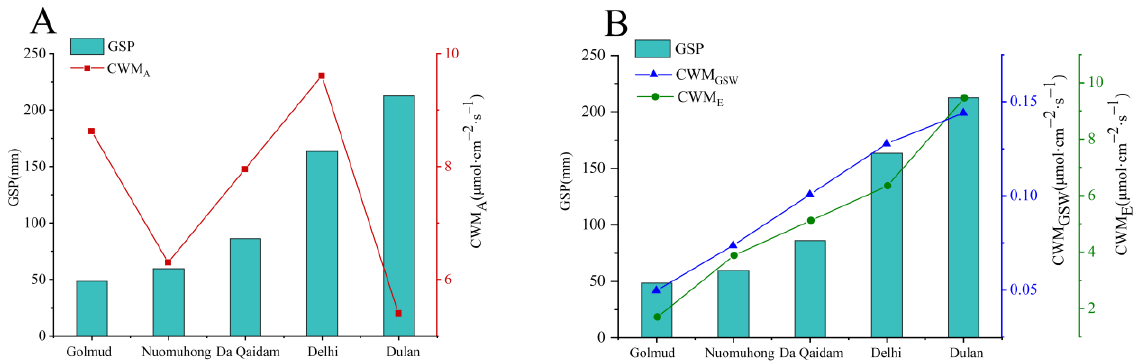
Figure 2. Variation in the community-weighted mean of leaf functional traits (CWM) along the precipitation gradient at different sites.